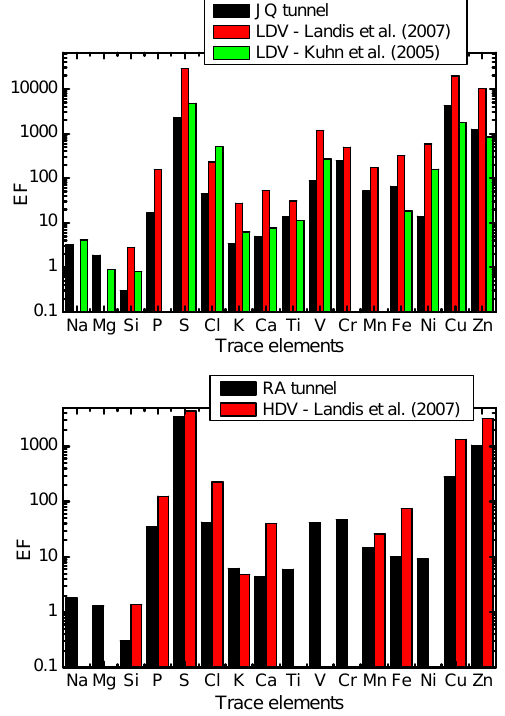
Fig. 5. Enrichment factor (EF) analysis relative to the UCC compo- sition using Al as reference material. Top: results of the JQ tunnel and previous works on gasoline-fuelled LDVs near a freeway (Kuhn et al., 2005) and in tunnel (Landis et al., 2007). Bottom: EF results from the RA tunnel and results for diesel-fuelled HDVs in tunnels (Landis et al.,